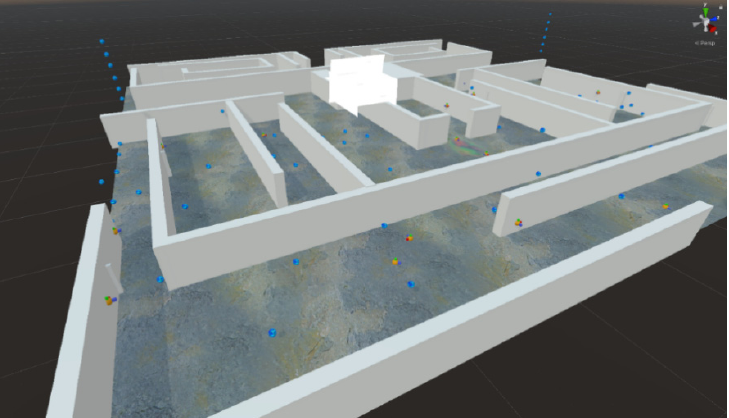
Figure 3. Initial configuration programmed in Unity of the space created for risk prevention and signal training.